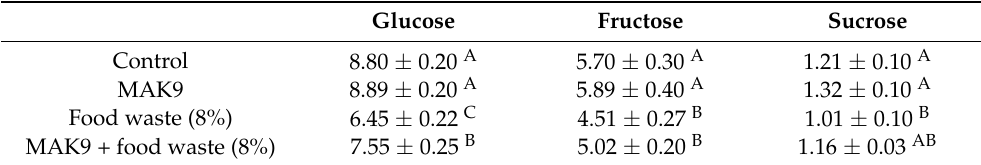
Table 2. Effects of Bacillus pumilus MAK9 on the total sugar content (glucose, fructose, and sucrose) of Chinese cabbage plants when administered with and without food waste